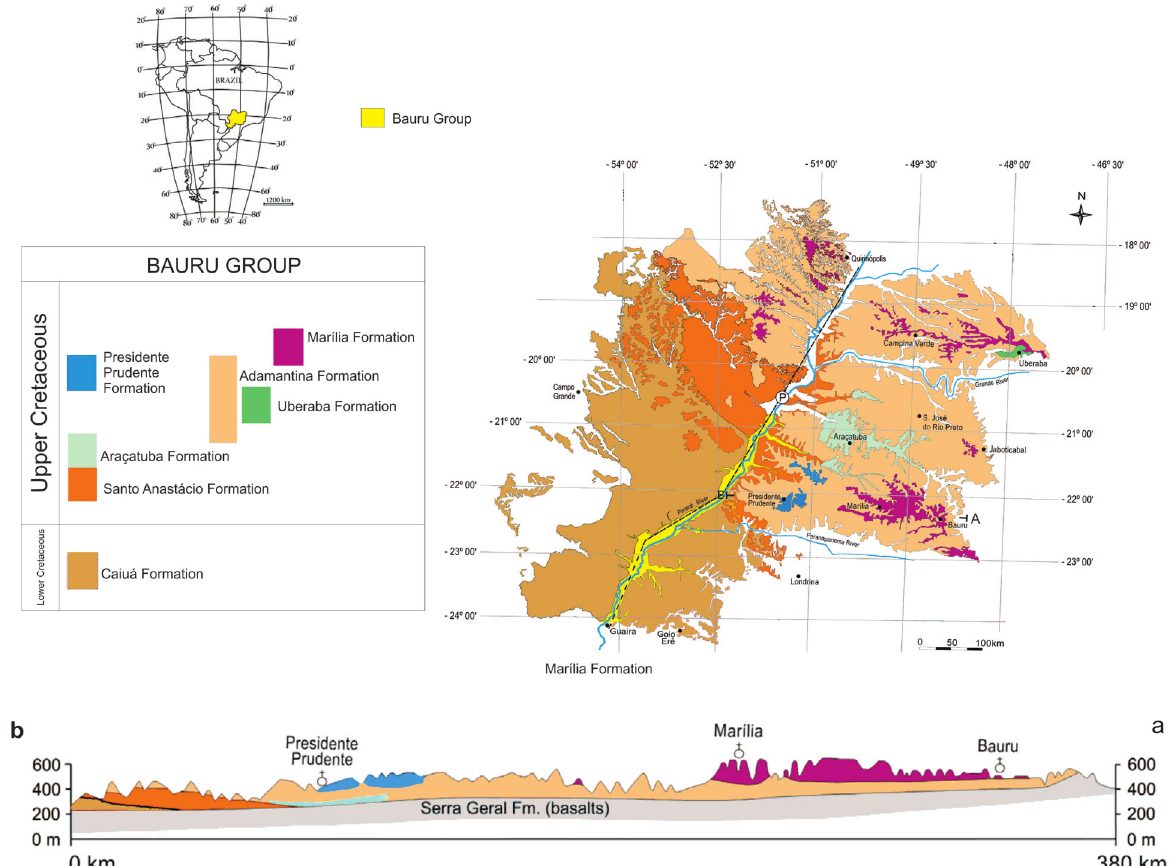
Figure 1 - Geological map of the Bauru Group with regional section a-b (modified from Fernandes and Ribeiro 2015). Figure by F.